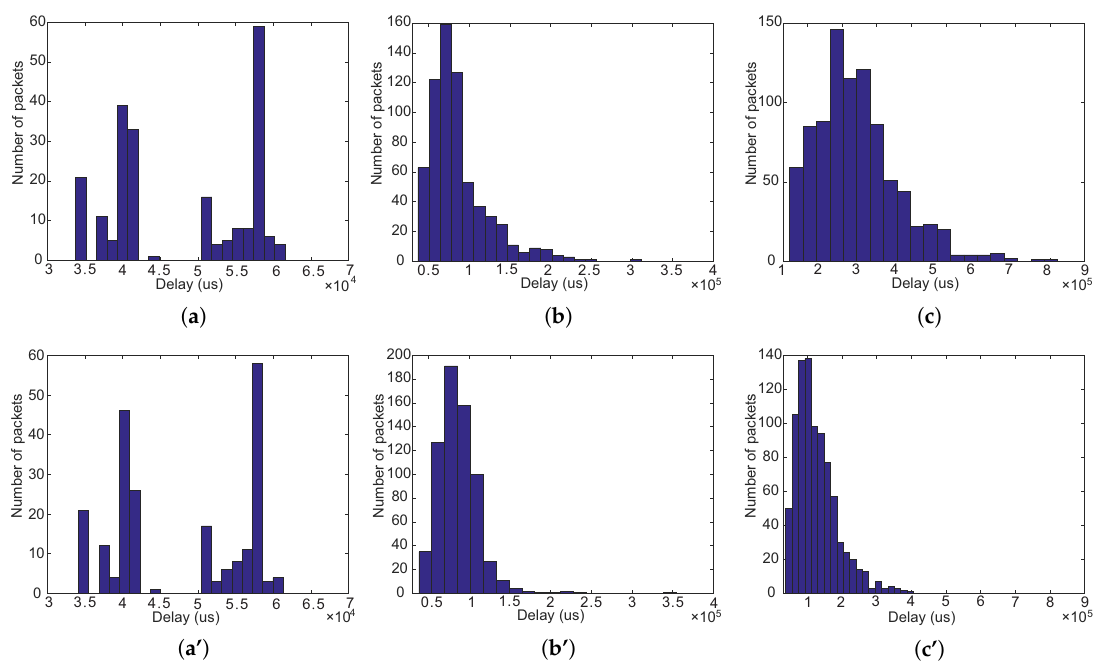
Figure 5. Comparison of delay distributions of packets between NCR and ANCR. ( a ) NCR: 220 packets, 2 data streams; ( a’ ) ANCR: 220 packets, 2 data streams; ( b ) NCR: 660 packets, 5 data streams; ( b’ ) ANCR: 660 packets, 5 data streams; ( c ) NCR: 880 packets, 20 data streams; ( c’ ) ANCR: 880 packets, 20 data